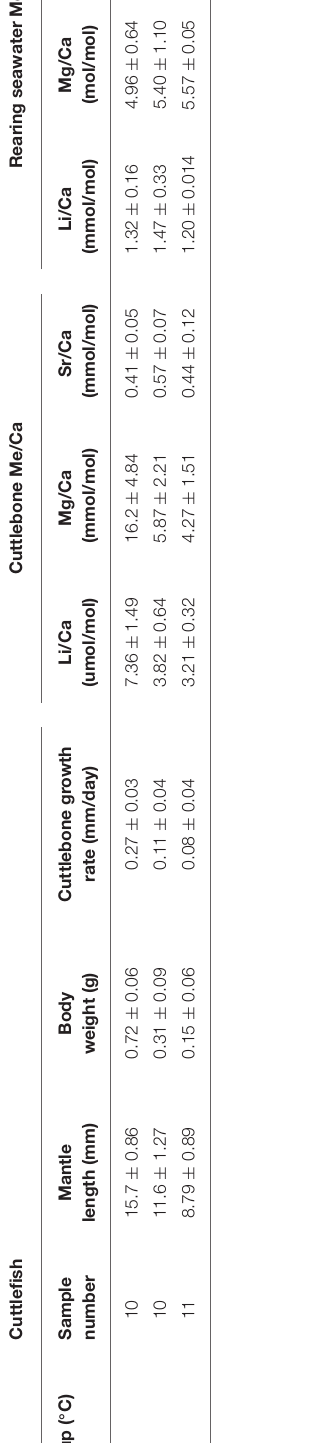
FIGURE 2 | Partition coefficients of Li/Ca (A) , Mg/Ca (B) and Sr/Ca (C) among temperature groups and in relation to cuttlebone growth